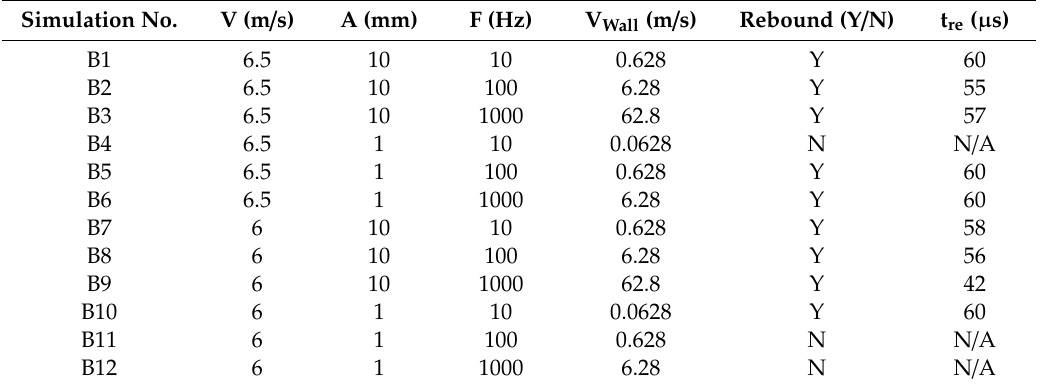
Table 3. Simulation results for isothermal droplet impingement onto a moving boundary. Y, yes; N, no. Simulation